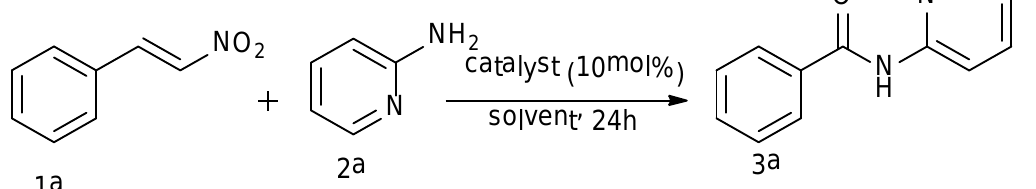
Figure 4. N 2 adsorption–desorption isotherms (left) and pore size distributions (right) of metal– organic framework (MOF) samples.